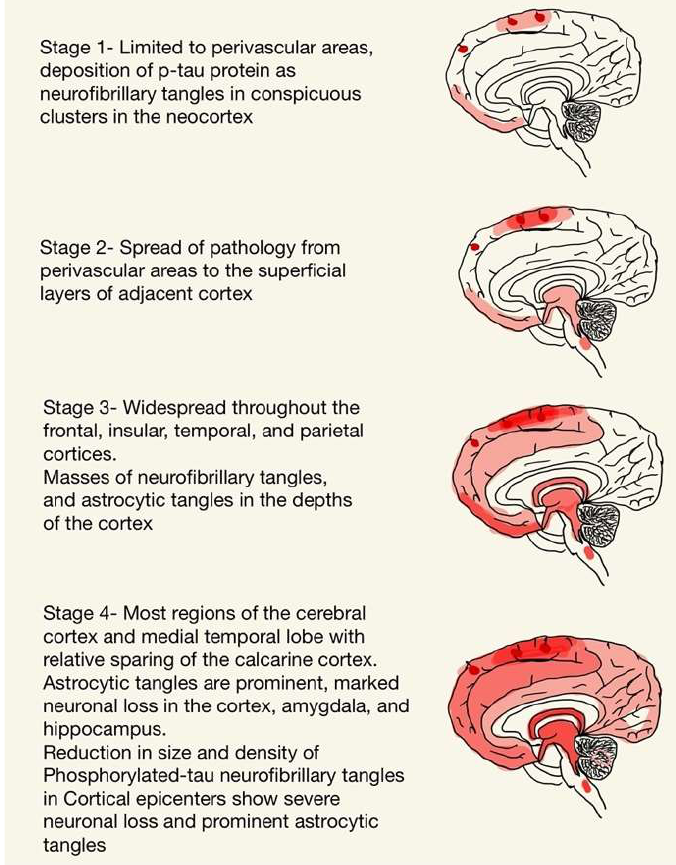
Figure 1. The progression of hyperphosphorylated p-Tau.